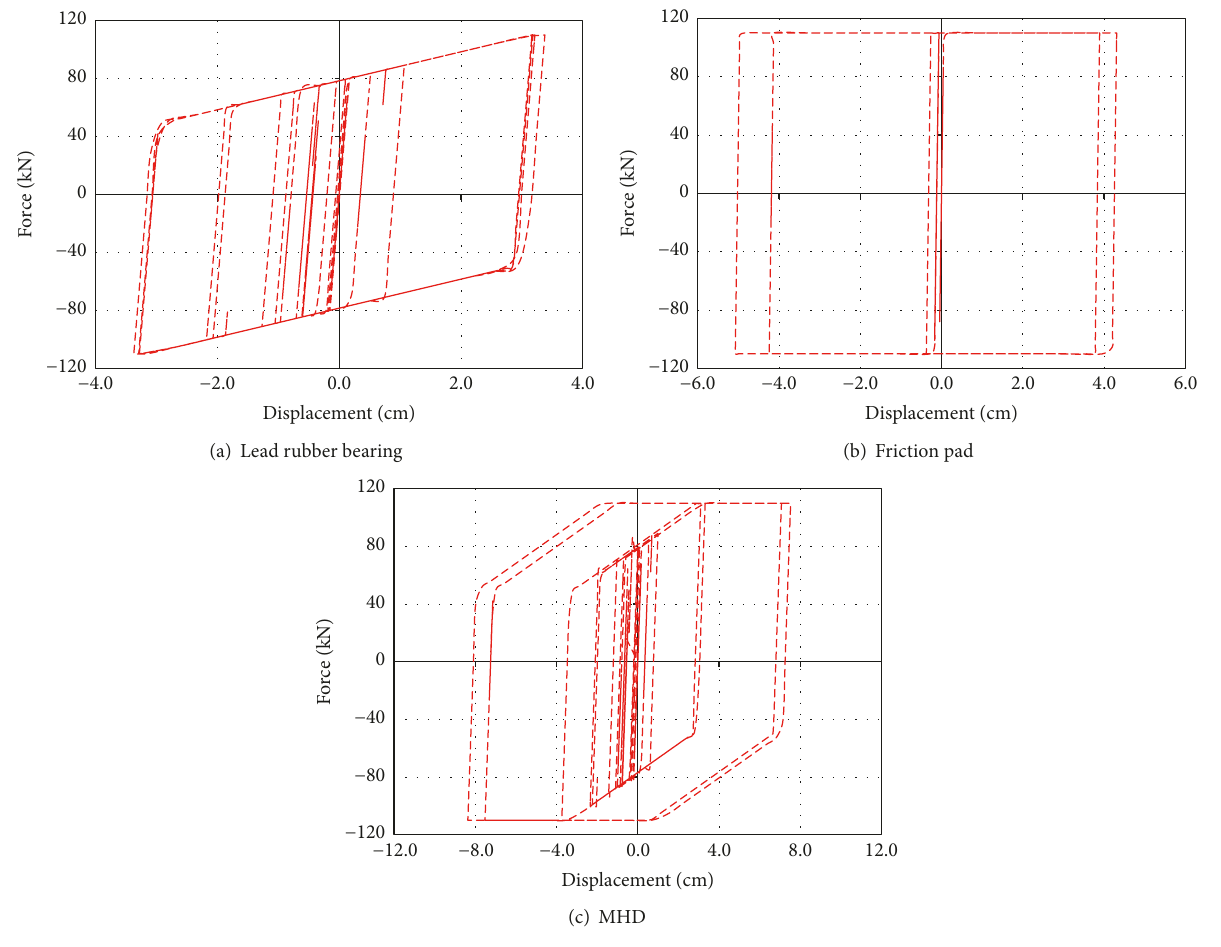
Figure 24: Hysteresis behavior from nonlinear